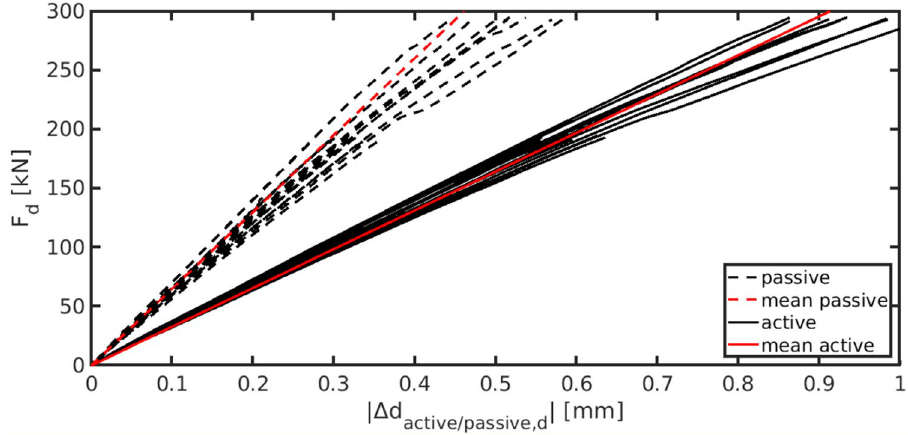
Fig. 8 Load versus displace- ment curves of the second and third loading cycles for the diaphragm shear